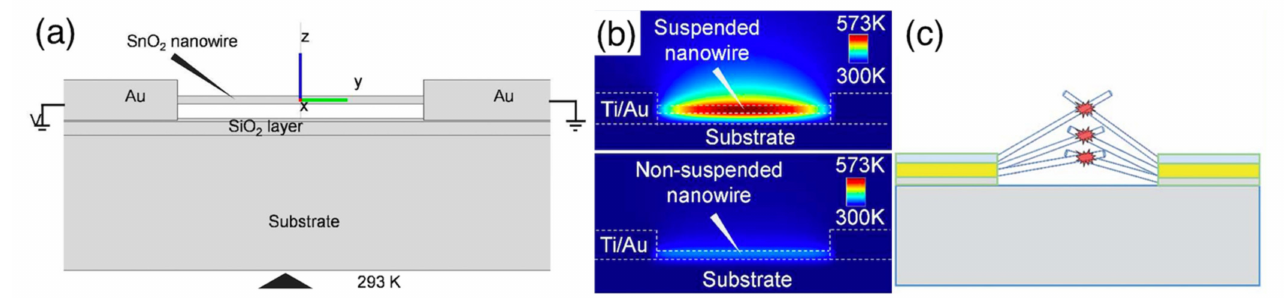
Figure 10. Self-heating. Schematic representation of the self-heating nanowire ( a ); simulation of temperature distribution along the nanowire for the suspended and not-suspended configurations ( b ); schematic representation of a self-heated nanowire network ( c ). Figure 10a,b are reprinted with permission from [183], Copyright 2016 American Chemical Society. Figure 10c is reproduced from Ref. [187] with permission from the Royal Society of